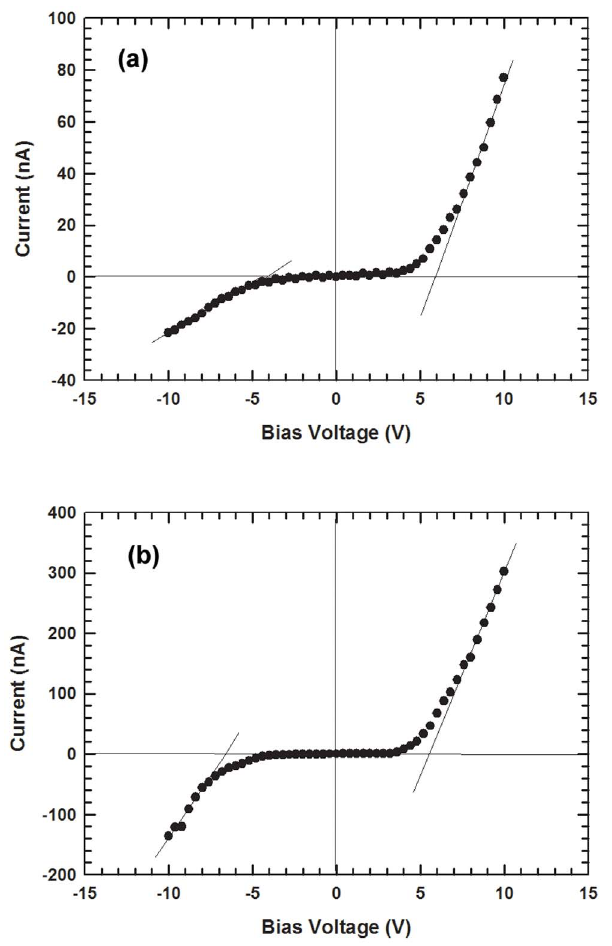
Figure 2. I–V behavior of the ZnO on type IIb diamond heterojunction under (a) dark condition and (b) UV illumina- tion.